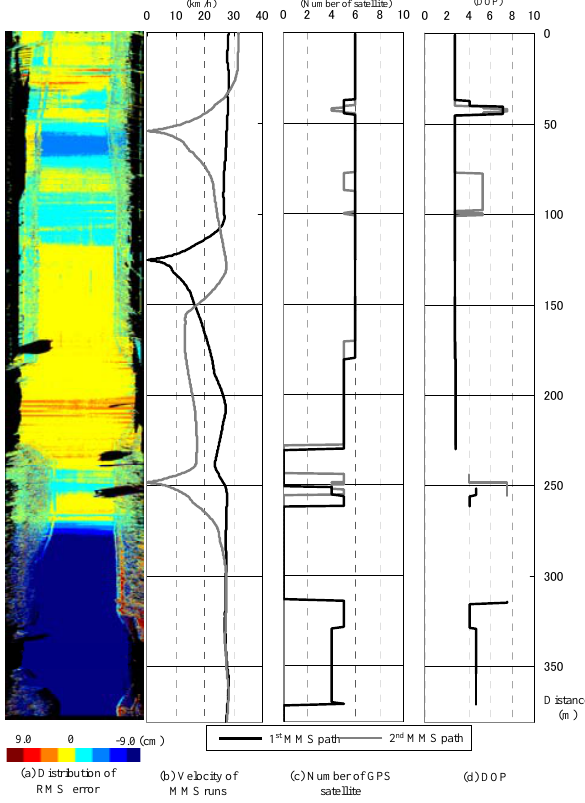
Figure 5. Result of Relative Accuracy